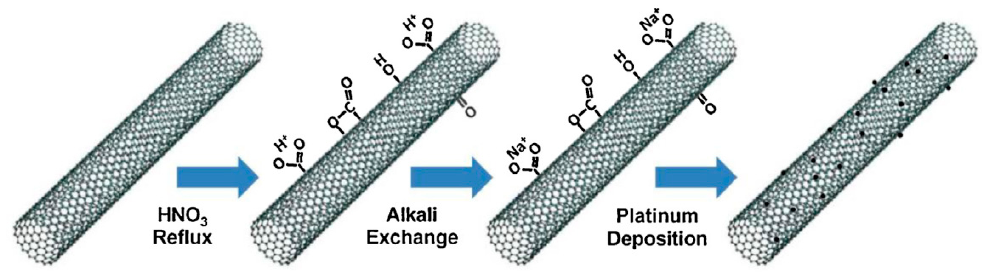
Figure 9. Schematic of the preparation of alkali-promoted Pt / MWNT catalysts, reproduced from [72], with permission from Elsevier, 2014.